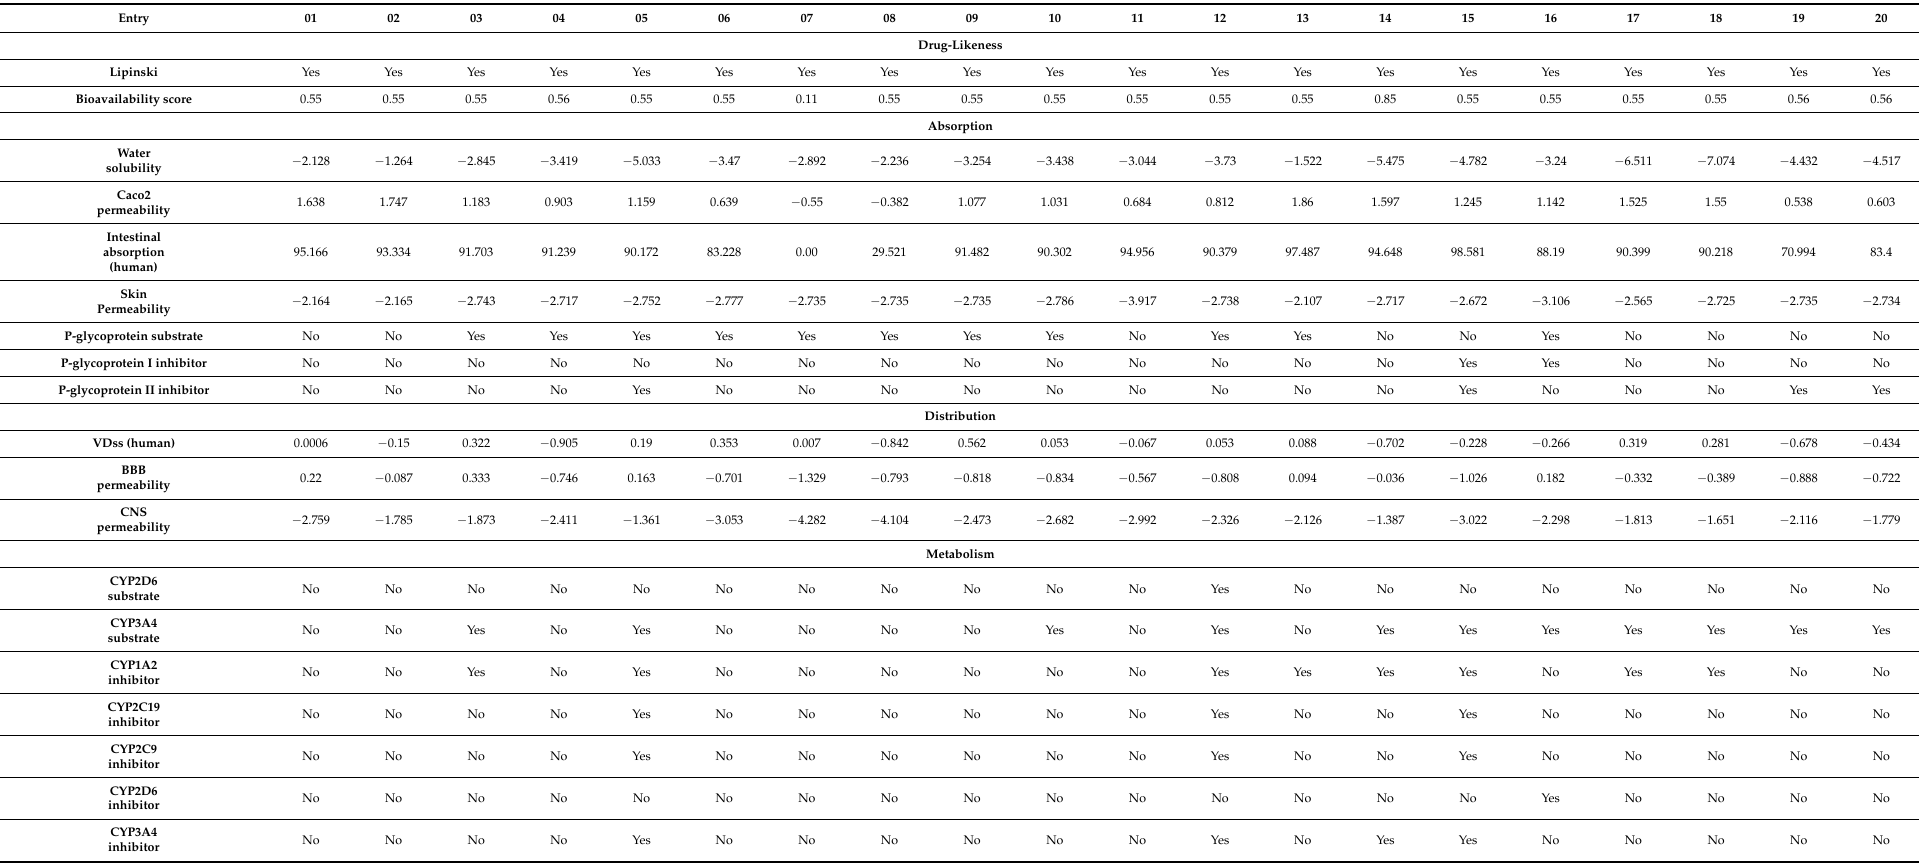
Table 2. Absorption, distribution, metabolism, excretion and toxicity (ADMET) properties of the identified phytochemical compounds of E. sativa : (1)